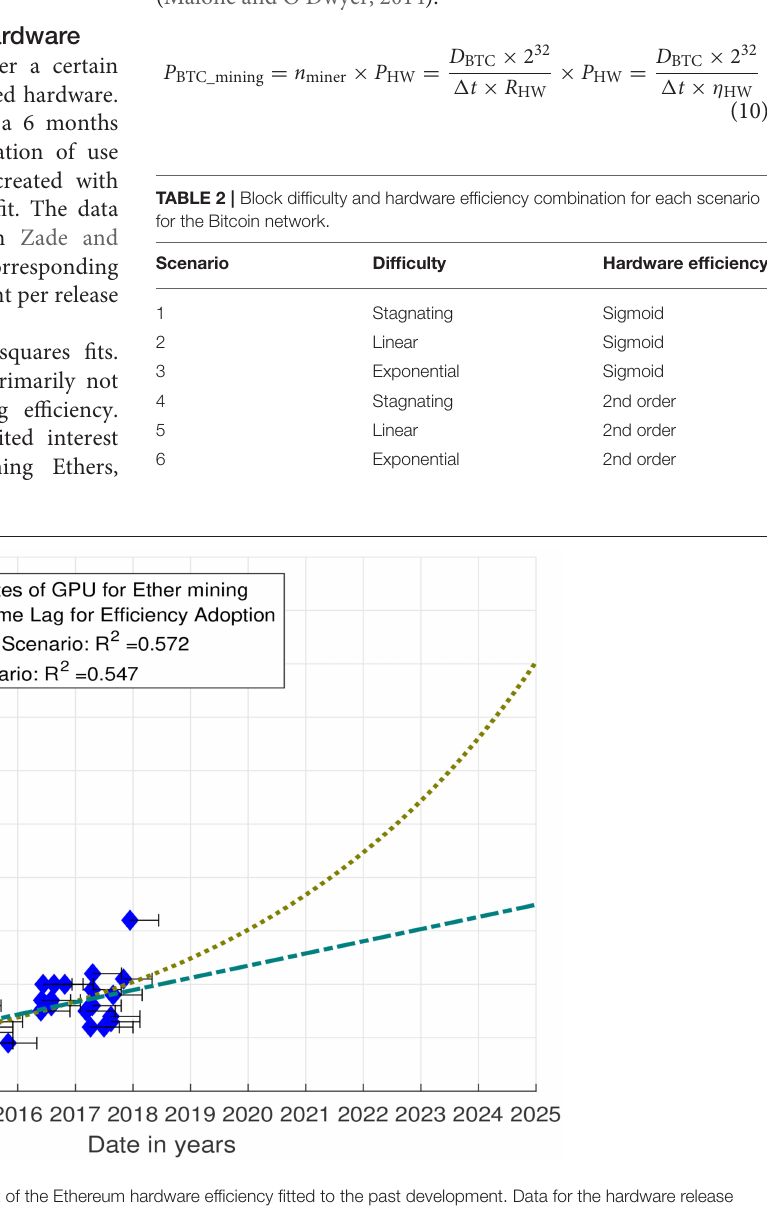
Frontiers in Energy Research |